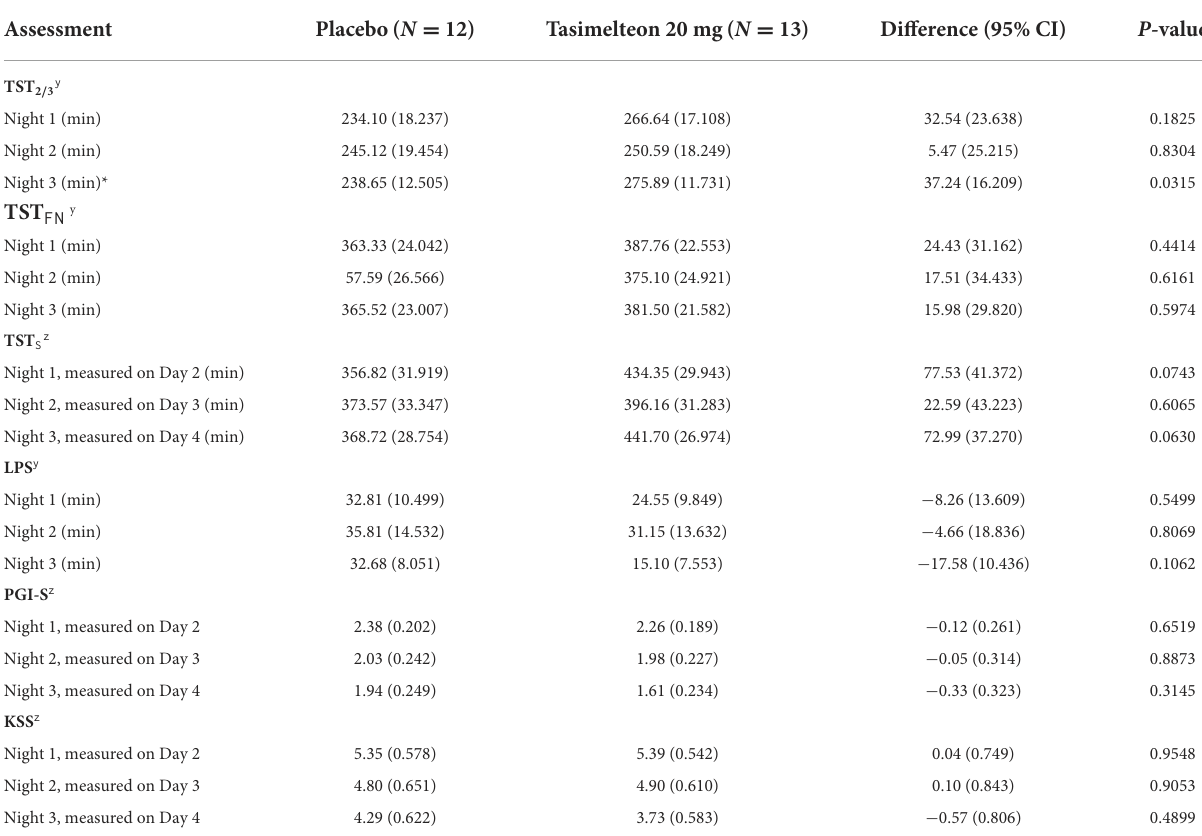
TABLE 2 Summary of endpoints for the ITT